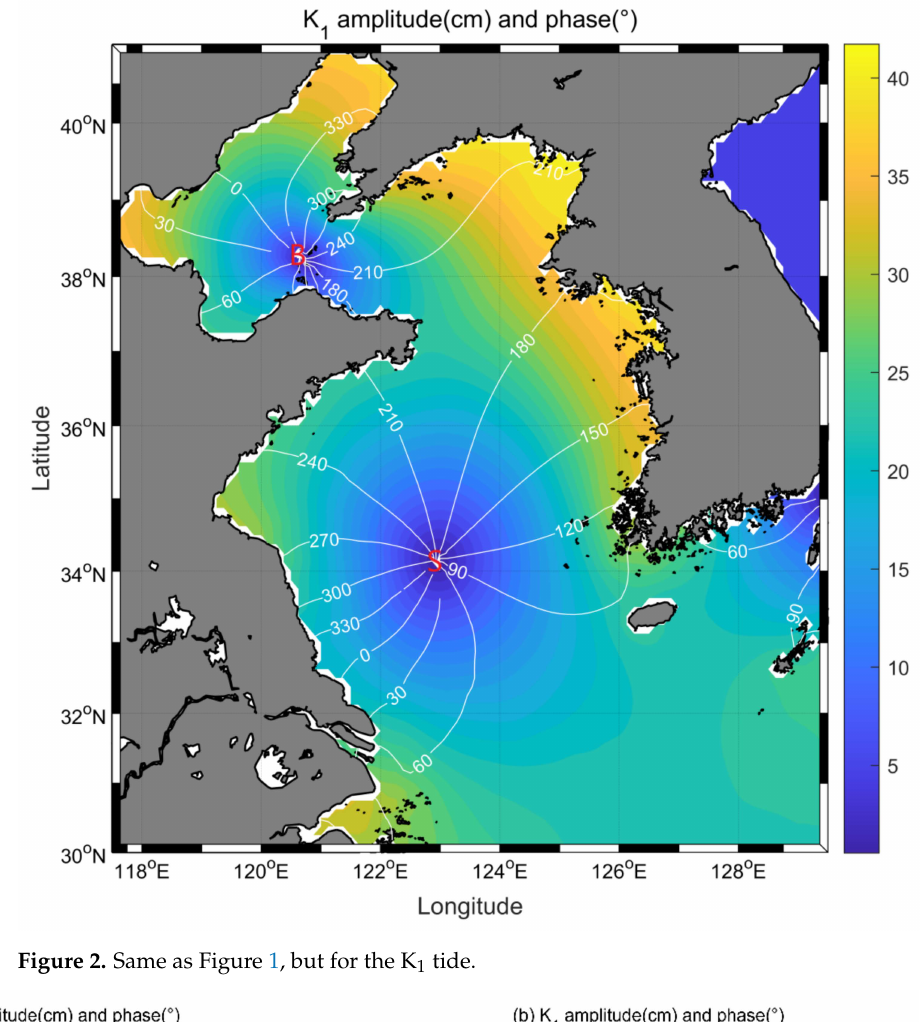
Figure 2. Same as Figure 1, but for the K 1 tide.